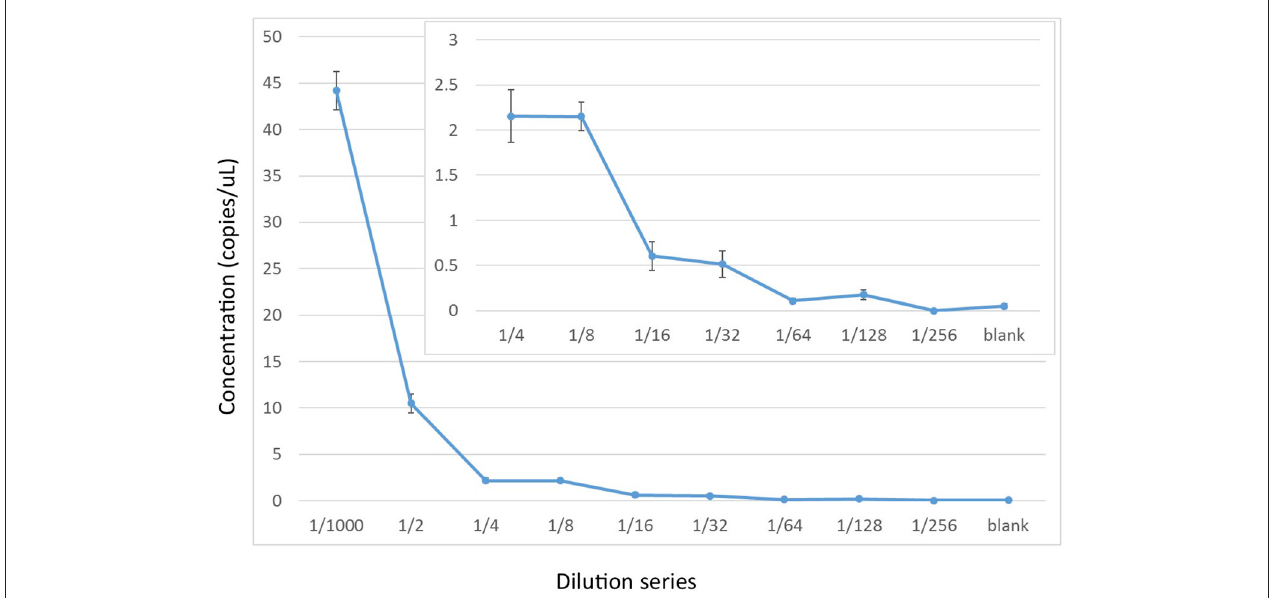
FIGURE 4 | Experimental limits of detection for cetacean mtDNA by ddPCR using a 2x dilution series starting with ∼ 60 pg of cellular DNA from a Hector’s dolphin (i.e., a 1/1,000 dilution of a 60 ng/ µ L stock). The ddPCR were run with 6 replicates using EvaGreen reaction mix to amplify a 139 bp fragment from Oordlp6.5 to dlp8G.